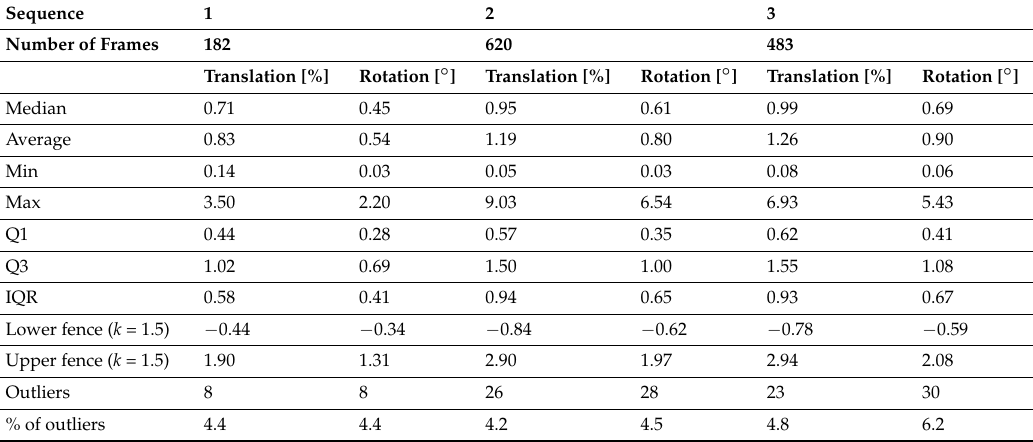
Table 2. Statistical accuracy evaluation of the three analyzed sequences of the King’s Chinese